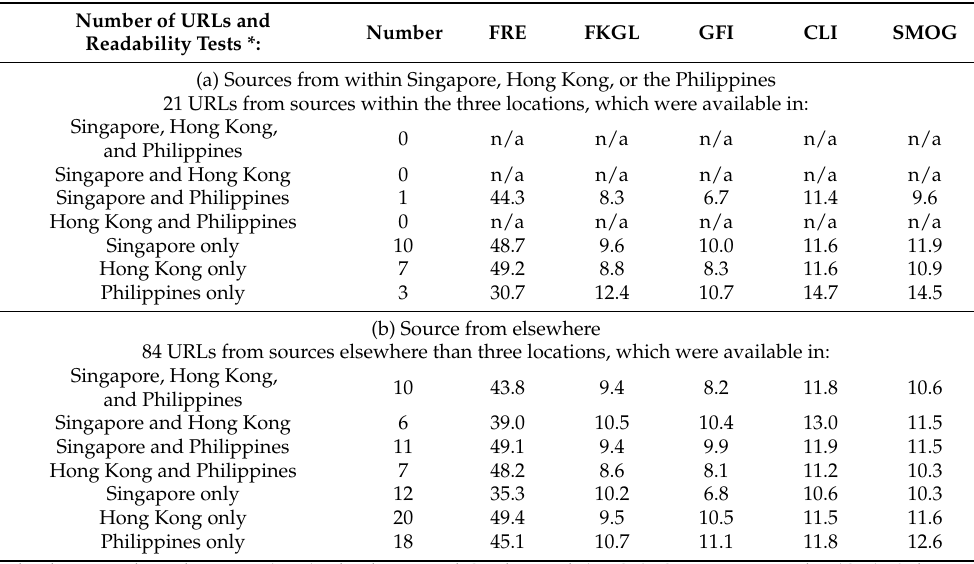
Table 4. Number of URLs and mean readability scores by presence of URL across locations and by origin of source.